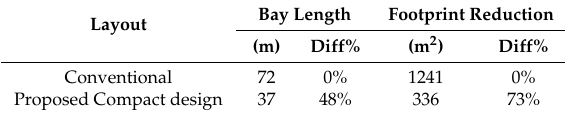
Table 5. Length and area reduction of a compact bay.